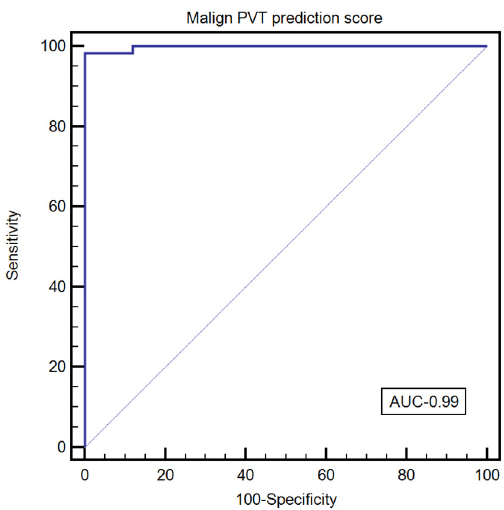
Figure 3. The performance of PVT score for the characterization of PVT. Based on the AUROC comparison, the PVT score performed better than CEUS (AUC—0.99 vs. AUC—0.93, p = 0.025) or AFP serum levels (AUC—0.99 vs. AUC—0.96, p = 0.047) for characterizing PVT (Figure